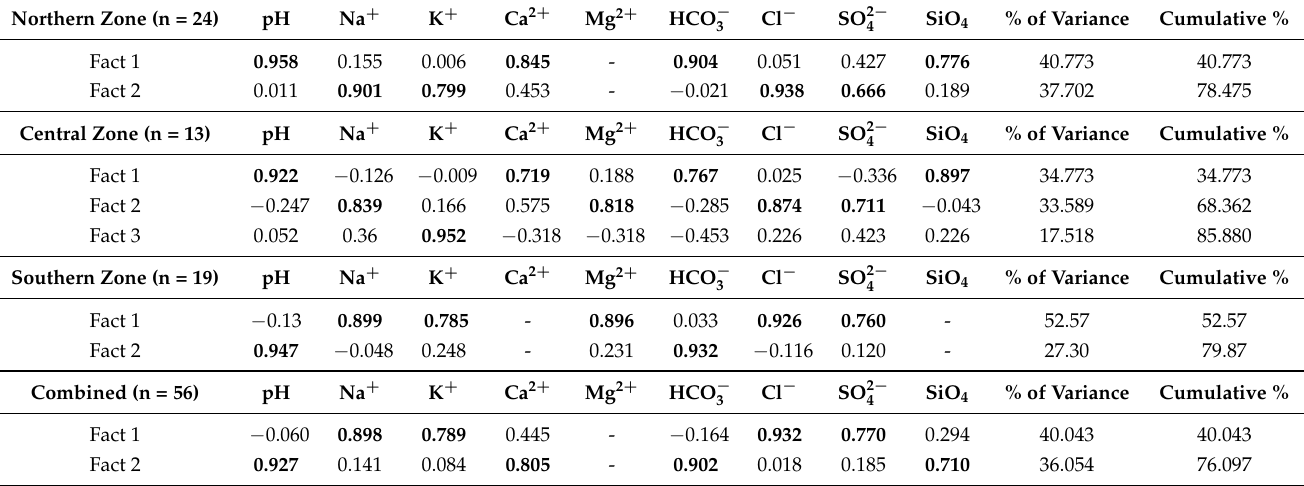
Table 3. Scores generated from the factor analysis explaining significant relationships between the hy- drochemical parameters. The dash symbols (-) indicate that the parameter loaded a communality less than 0.5 and was deemed statistically insignificant and thus was not considered for the factor